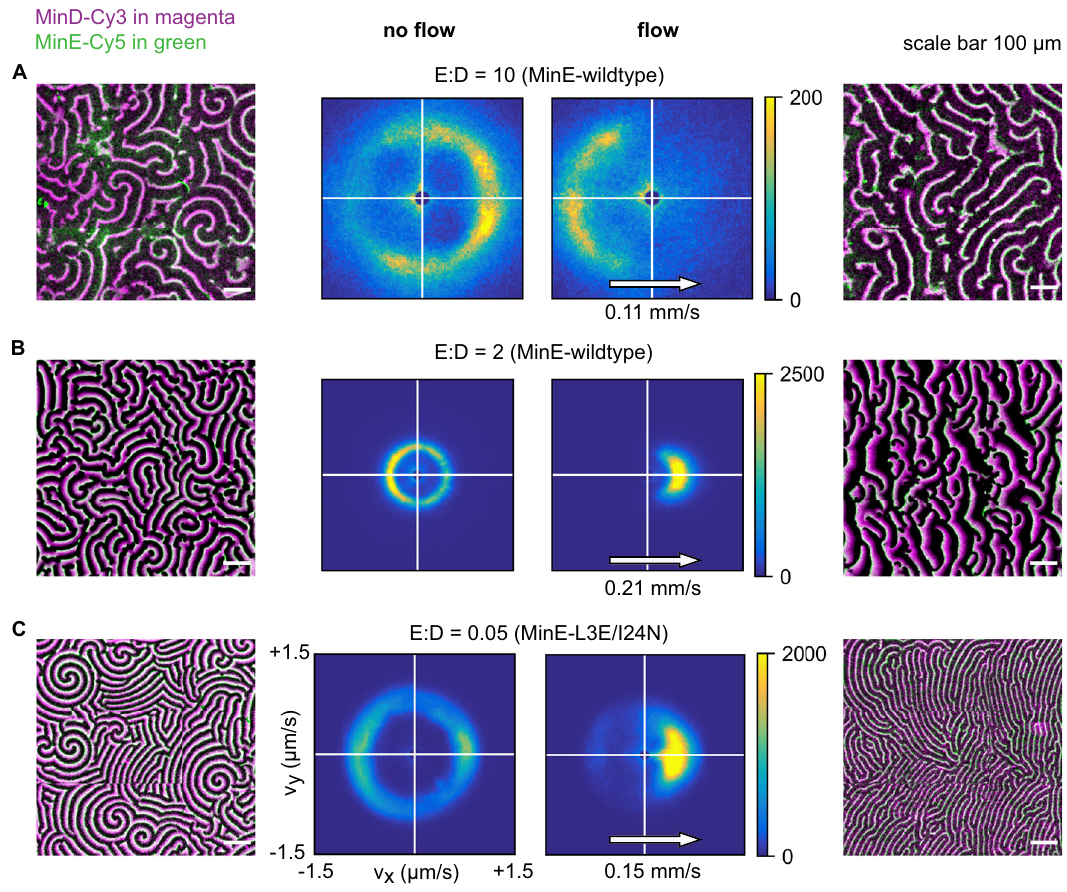
Fig. 2 | Experimental data showing how patterns respond to fl ow at different E:Dratios. DataareforMinE-wildtype( A , B )and MinE-L3E/I24N( C ),withbulk fl ow directedleft-to-right.Minpatterns(outerleftandouterrightcolumns)showMinD- Cy3 in magenta and MinE-Cy5 in green. All scale bars are 100 μ m. The results of wave-propagation analysis calculated for MinD-Cy3 data are represented as 2D histograms (center columns) with binning size (25nm/s) × (25nm/s), showing countsfordirectionality( v x ,v y ).Lefthalfofthe fi guresdisplaysanexemplaryimage